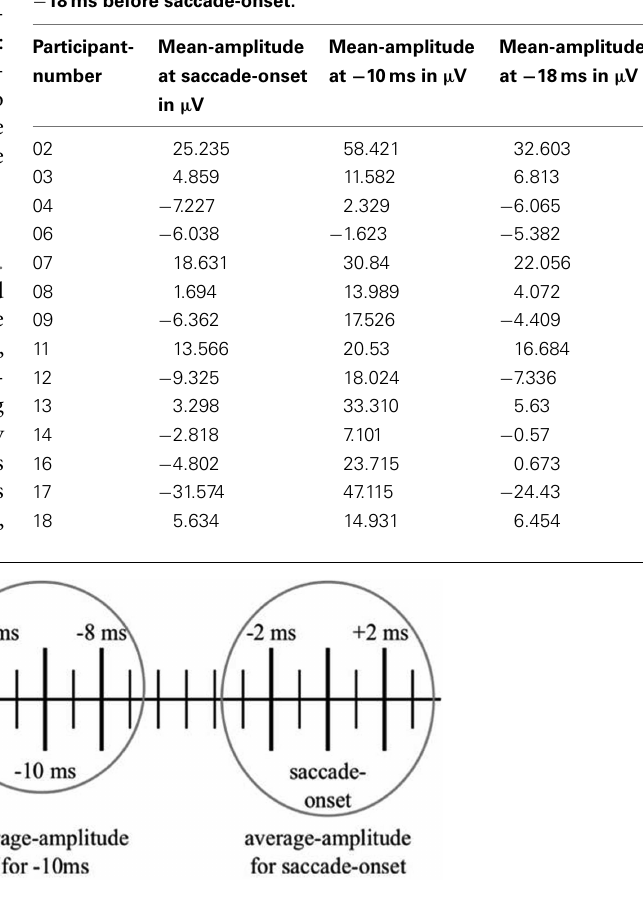
vertical lines represent the time-points from which the amplitudes have been noted.Then, these three amplitudes were used to calculate the mean-amplitudes for the respective